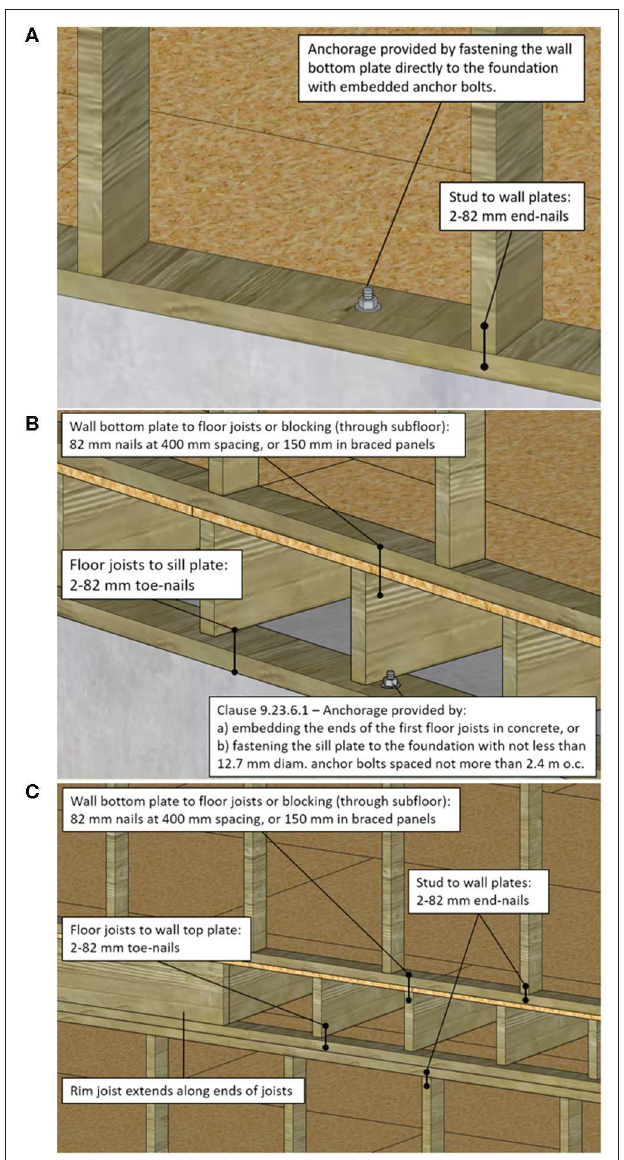
FIGURE 6 | Wall bottom plate connection alternatives, including (A) direct wall bottom plate anchorage (as idealized in past research) and nailed connections for (B) first-story walls and (C) Inter-story floor structure. (B,C) represent common details built in accordance with NBCC (Canadian Commission on Building and Fire Codes, 2015) Part